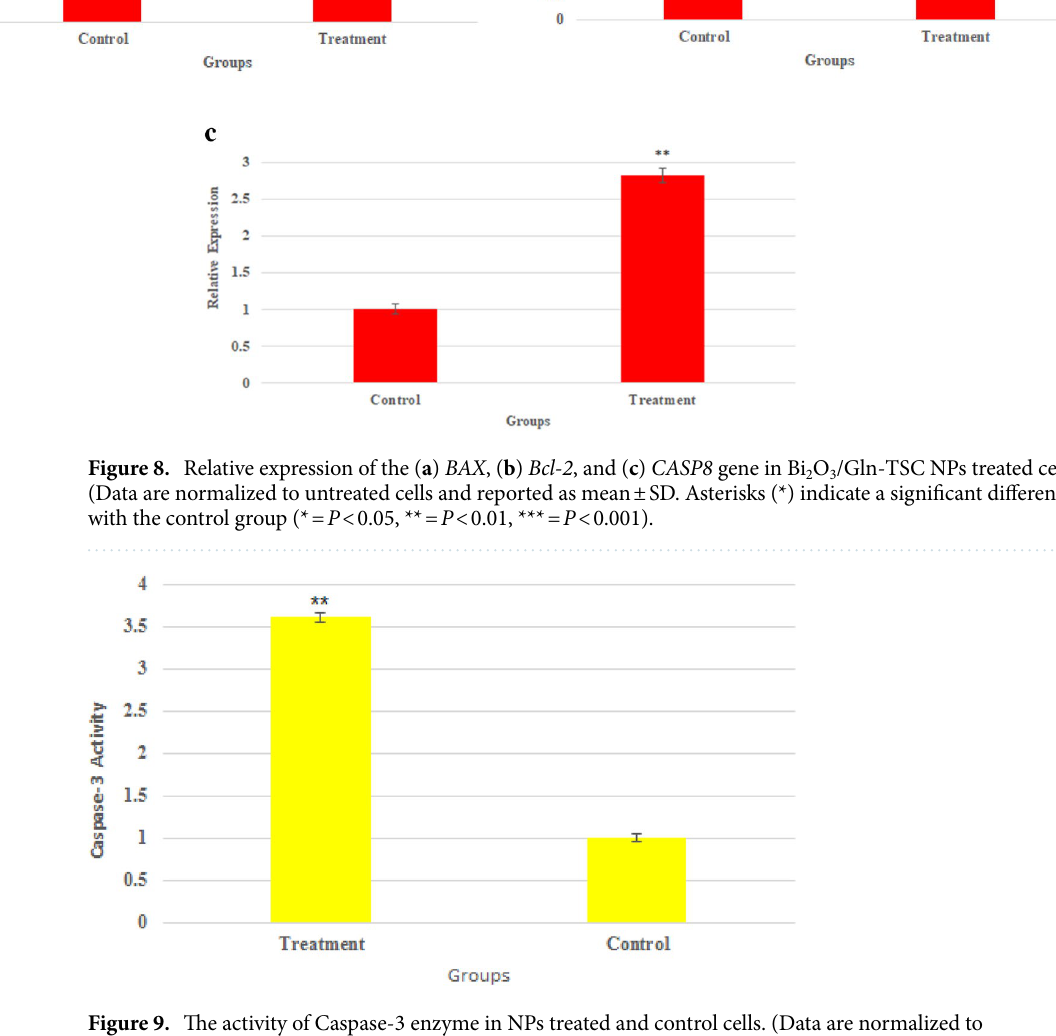
Figure 9. The activity of Caspase-3 enzyme in NPs treated and control cells. (Data are normalized to untreated cells and reported as mean ± SD. Asterisks (*) indicate a significant difference with the control group (* = P < 0.05, ** = P < 0.01, *** = P <